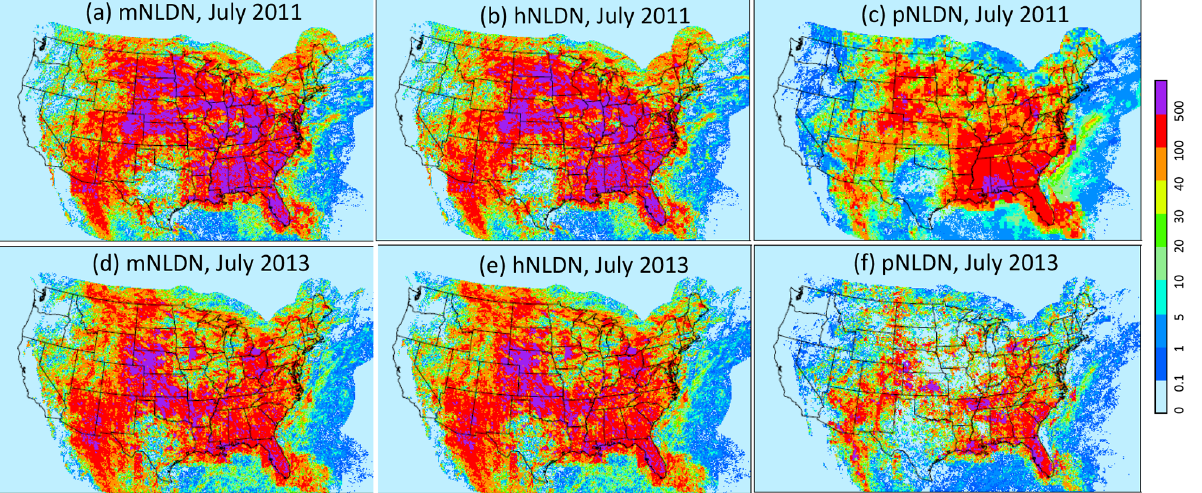
Geosci. Model Dev., 12, 3071–3083, 2019